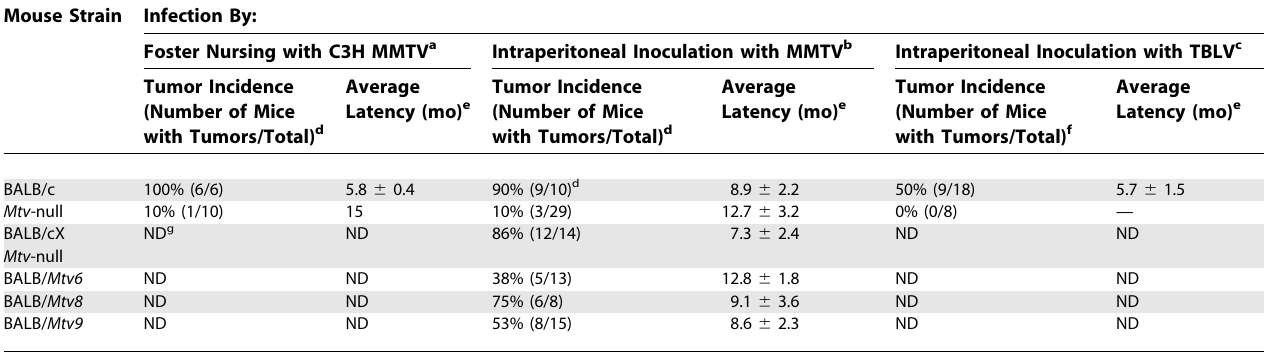
Table 1. Tumor Incidence of Mice Infected with MMTV or TBLV Mouse Strain Infection By: Foster Nursing with C3H MMTV a Intraperitoneal Inoculation with MMTV